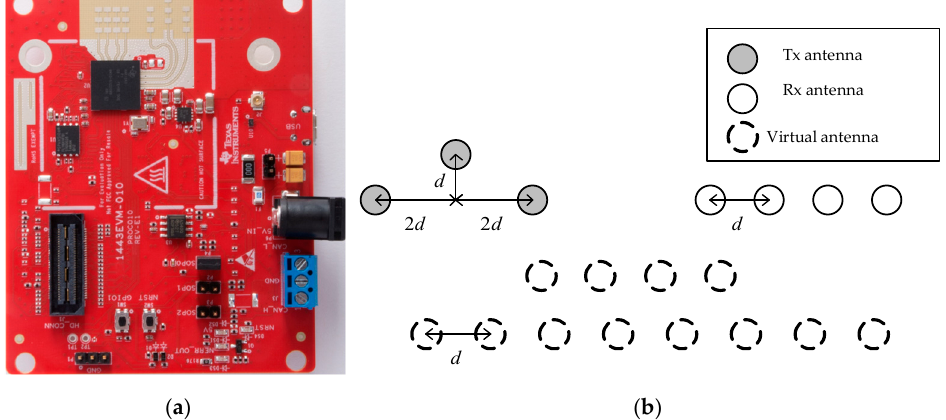
Figure 2. Radar system: ( a ) Structure of radar system; ( b ) Antenna array element and virtual aperture. The MMW array radar has an initial frequency of 77 GHz and a bandwidth of 4 GHz, which can provide better range resolution, while multiple aperture detection provides more azimuth angle data.